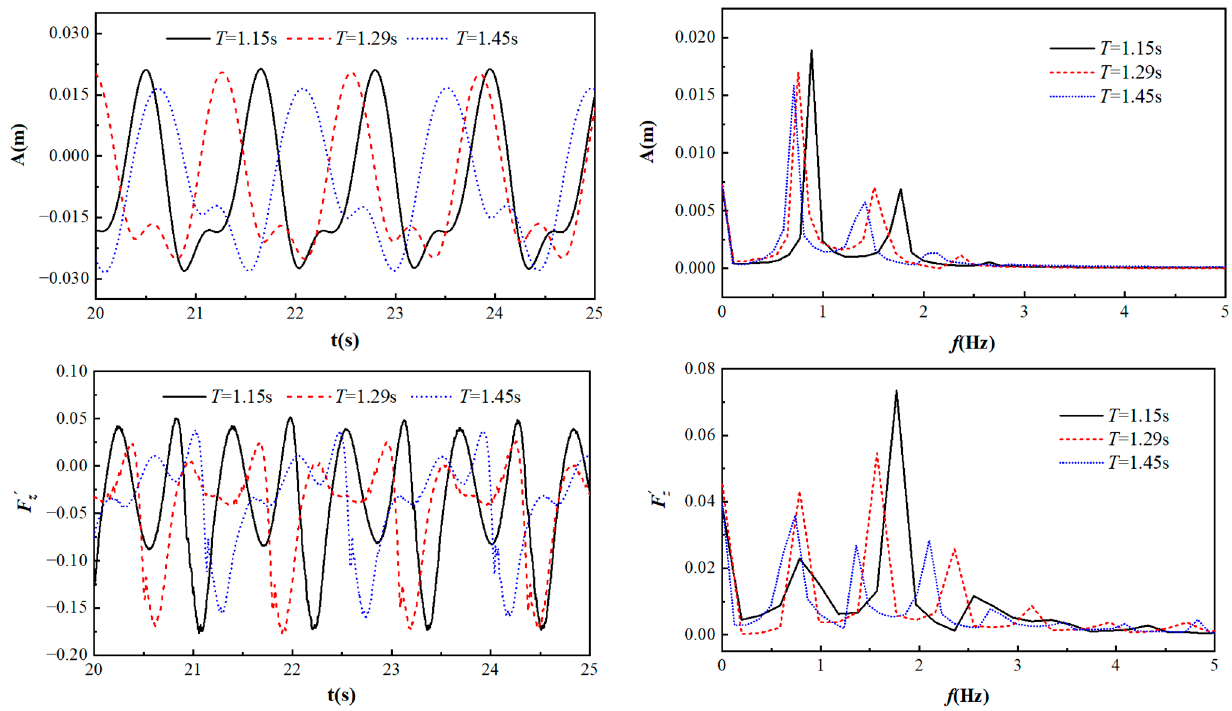
Figure 15. Time series curve and spectrum of wave–current force on cylinder under different peri- ods.